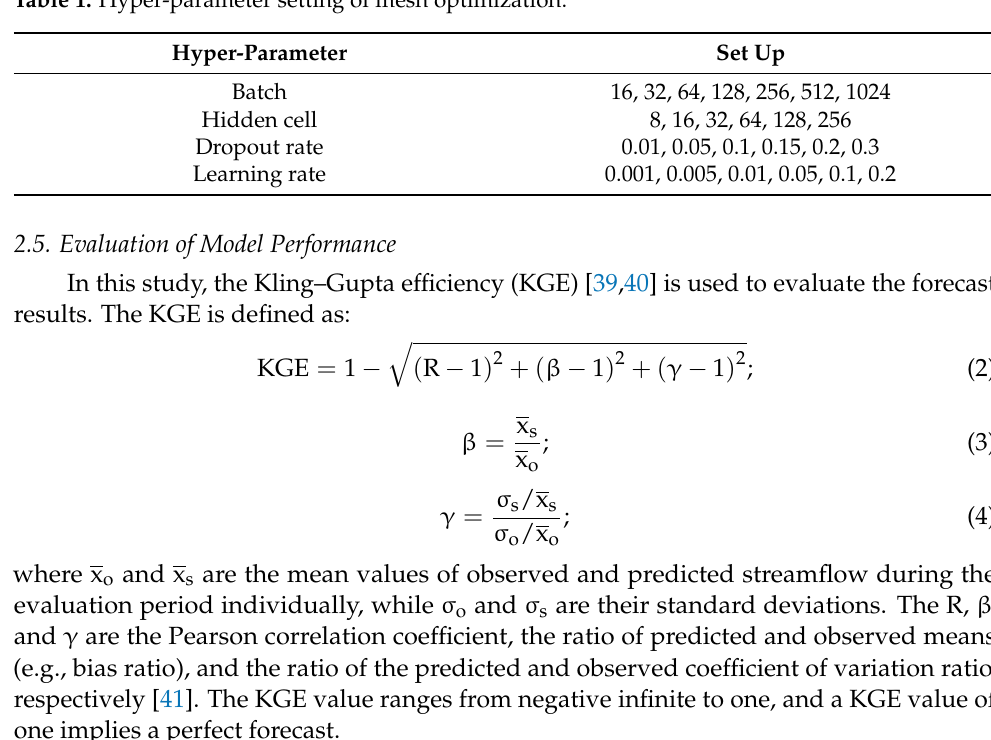
Table 1. Hyper-parameter setting of mesh optimization.